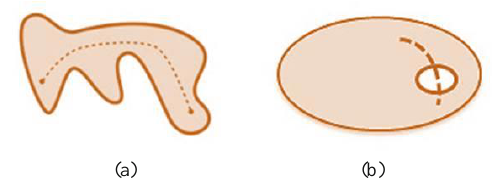
Figure 2. A (a) contiguous and (b) non-contiguous